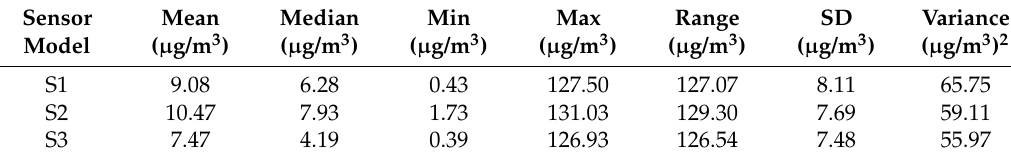
Table 4. The statistical summary for inter-sensor variability for three SDS011 sensors.